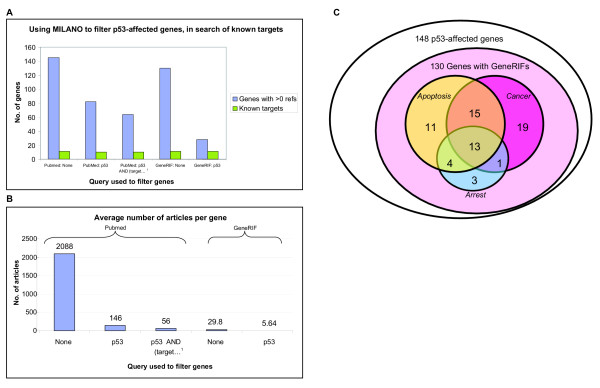
Analysis of a list of genes affected by p53 overproduction. A. The number of genes remaining after filtering the p53-affected genes with terms intended to reveal known p53 targets. B. Average number of articles per gene in the different queries. C. Venn diagram depicting the different functions of p53 affected genes as reflected by a GeneRIF search. 1Search term is "p53 AND (target OR transcriptional OR activation OR repression)"